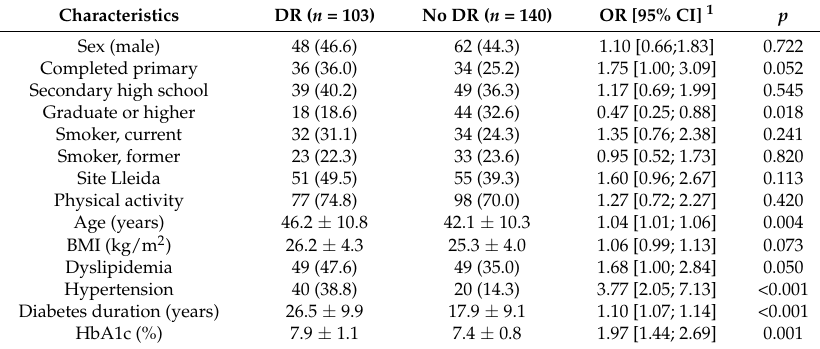
Table 3. Bivariate analysis for the relationship between the presence of diabetic retinopathy and clinical characteristics.